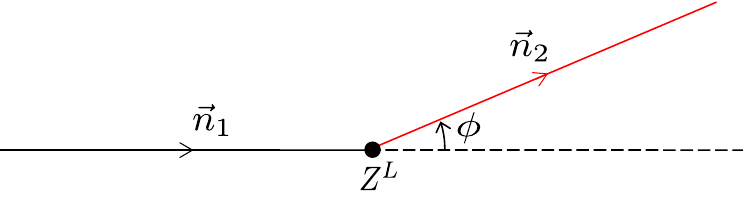
Figure 2 . Cusped Wilson line with insertions. The cusped Wilson line consists of two semi-in(cid:12)nite lines which intersects with an angle (cid:30) at the origin, and the insertions Z L . The scalar coupling of each semi-in(cid:12)nite line is given by the vector ~n 1 ; 2 , and the relative angle between the two vectors is (cid:18) . The divergence from this Wilson line is controlled by the generalized Bremsstrahlung